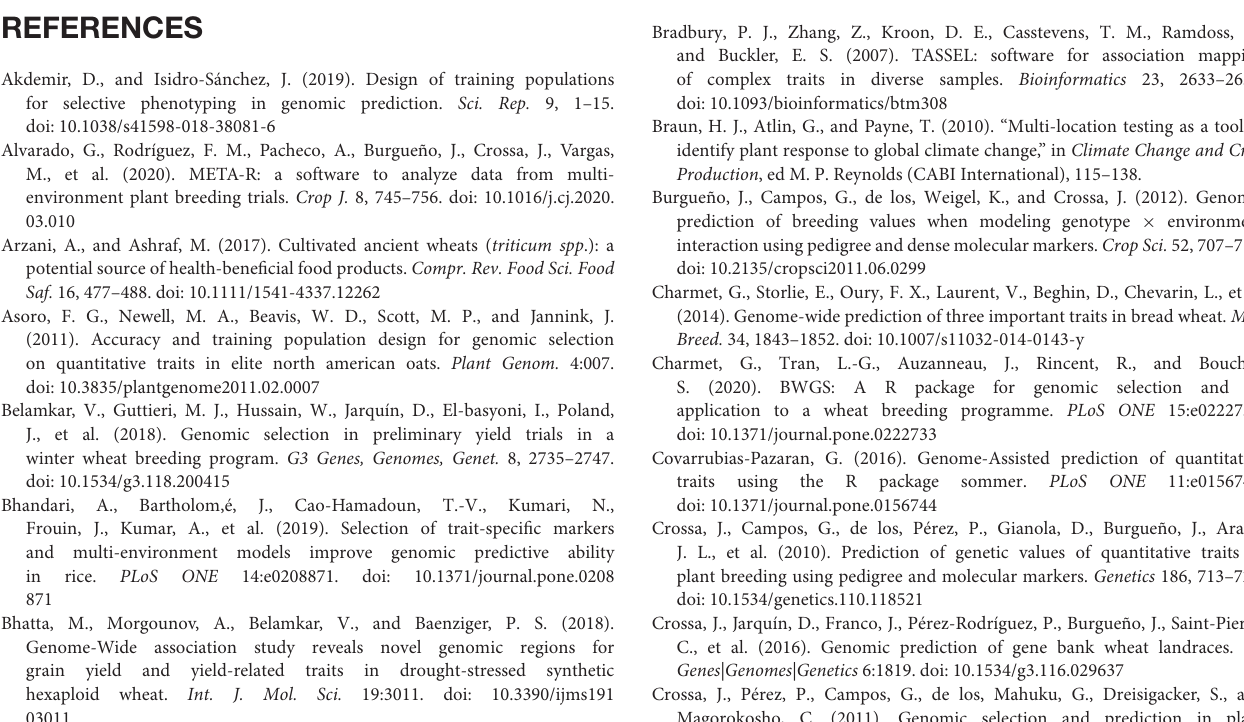
Supplementary Figure 1 | Weather information of LDH17 and LDH18. Supplementary Figure 2 | Weather information of JBL17 and JBL18. Supplementary Table 1 | List of 141 genotypes with pedigree information used in this study. Supplementary Table 2 | List of traits that were evaluated during this study in the field trials. Supplementary Table 3 | GBS HapMap data used in this study. Supplementary Table 4 | Best linear unbiased predictions (BLUPs) data used in this